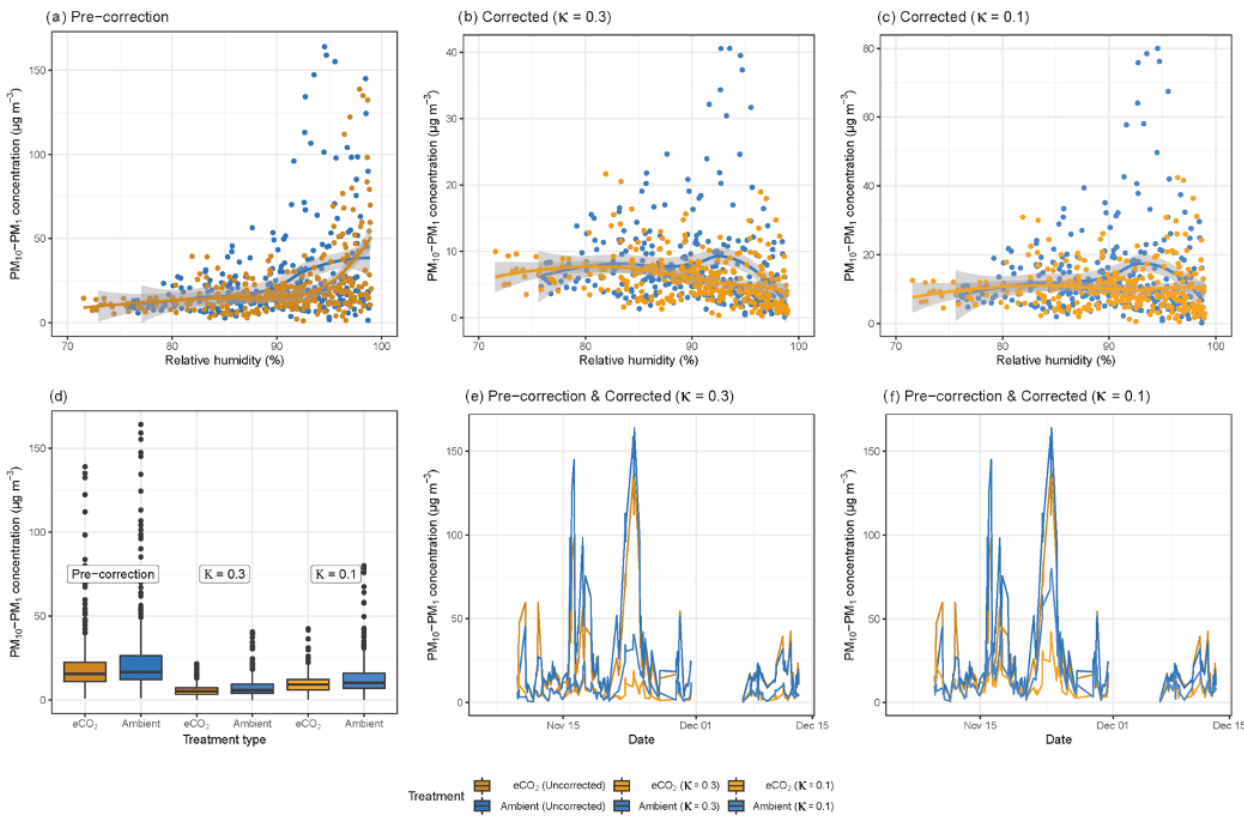
Figure 2. Relative humidity and bioaerosol concentrations (PM 10 –PM 1 ) at the BIFoR FACE site in autumn 2018. Panel (a) shows PM 10 – PM 1 concentrations with increasing RH without any correction applied. Panels (b) and (c) plot the same data as panel (a) ; however a correction factor from Crilley et al. (2018) has been applied to the bioaerosols data to correct for the hygroscopic effect of the particles, with panel (b) using a κ value of 0.3 and panel (c) using a κ value of 0.1. Panels (a) , (b) , and (c) all have loess curves fitted (Wickham et al., 2019). Panels (d) , (e) , and (f) compare the data before and after corrections. All the plots show PM 10 –PM 1 concentrations under ambient conditions (arrays 2, 3, and 5) in blue colours and e CO 2 conditions (arrays 1, 4, and 6) in orange colours. Pre-correction data are dark orange and blue; corrected data using a κ value of 0.3 are mid blue and mid orange; and the corrected data using a κ value of 0.1 use the lightest blue and orange. All panels use hourly averages of PM 10 –PM 1